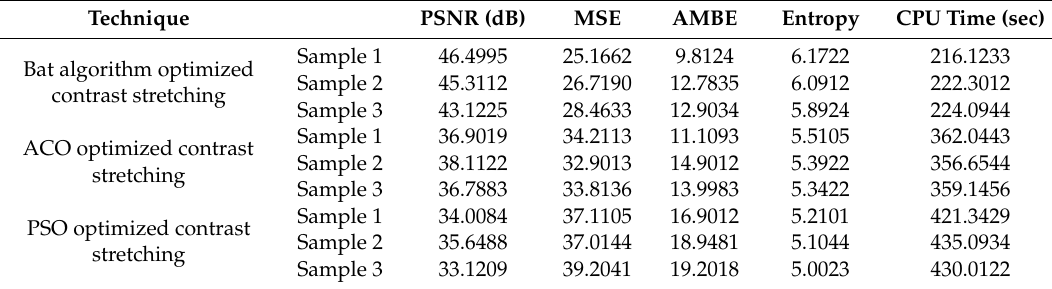
Table 2. Performance comparison for various